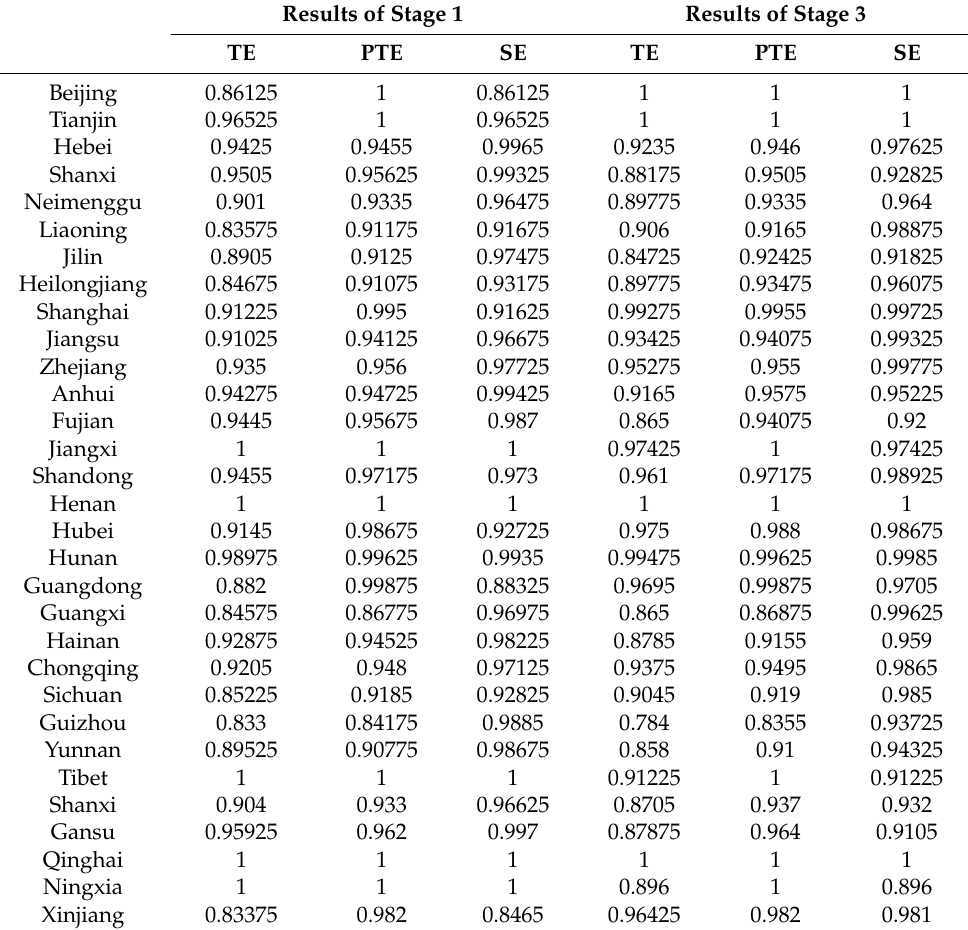
Table 6. Efficiency comparison of the basic medical insurance before and after the